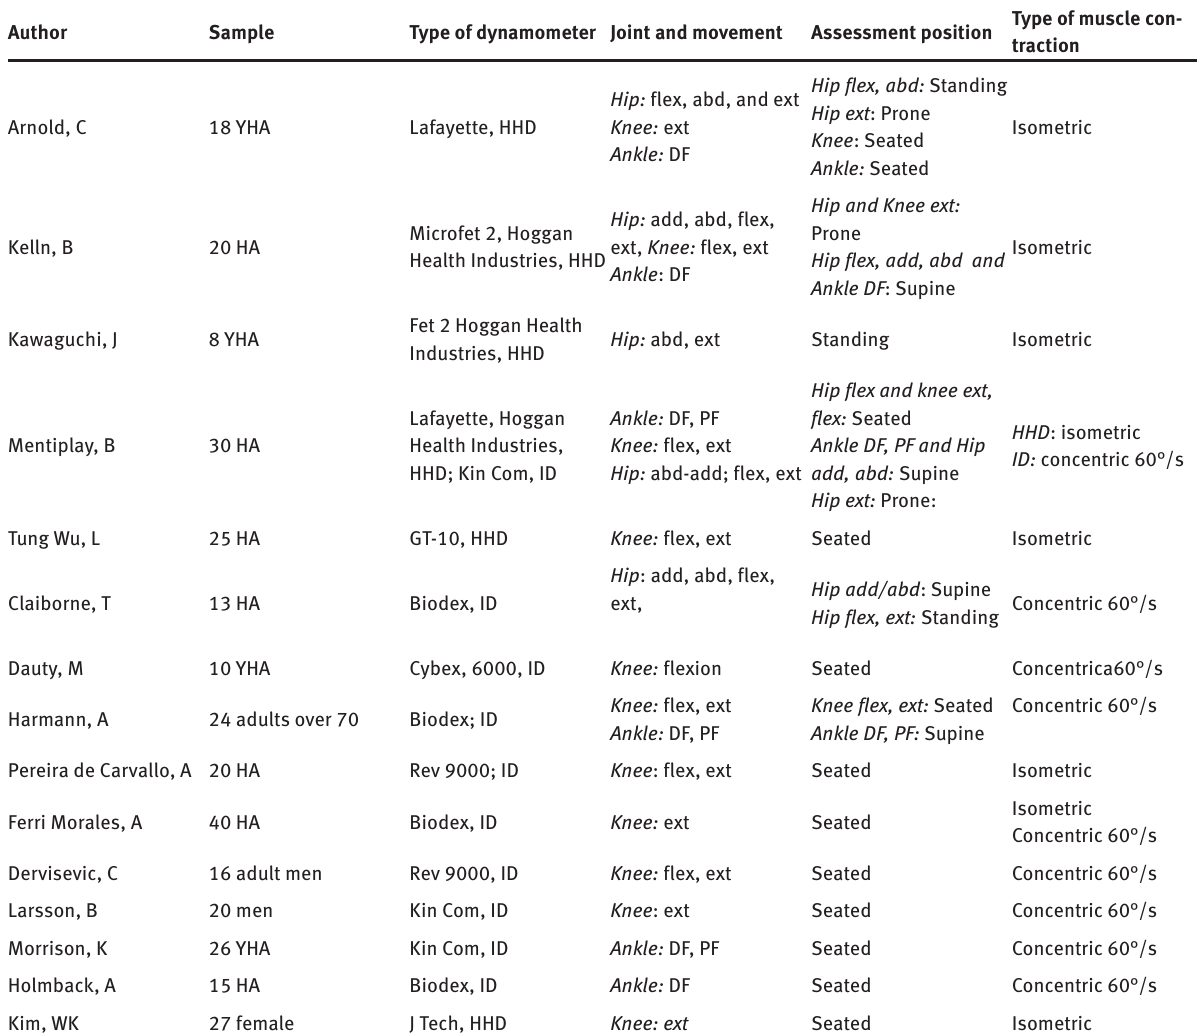
Table 1: Characteristics of Selected Studies Analyzing Absolute Reliability of HHD and